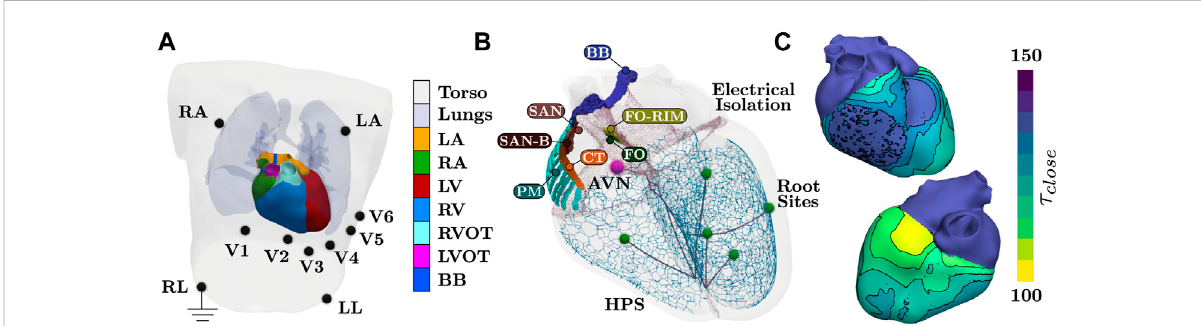
FIGURE 1 SetupofthetorsoandwholeheartEPsimulations. (A) Tissuelabelspresentwithin themodel. Bloodpoolswithintheheartarenotvisualized.All electrodesfor12leadECGarerecoveredfromtheMRIimageofthesubject,withRLelectrodeservingaselectricalground. (B) Anatomicalstructures pertaining to cardiac EP. Structures of SAN block (SAN-B), pectinate muscles (PM), and CT are assigned generic EP. The AVN and the SAN facilitate activation, where the BB is assigned a higher CV to facilite coordinate activation of the atria. Each terminal cable before a root site is applied a different CV to control activation timings of the fascicles of the HPS. (C) Prescribed τ close parameters of the Mitchell-Schaeffer model needed to facilitate a physiological T-wave. Values within the ventricles are computed from the Eikonal activation map. Both atrial tissues and the HPS are assigned the maximal value. Isolines and binning of the color bar indicates 5 ms.